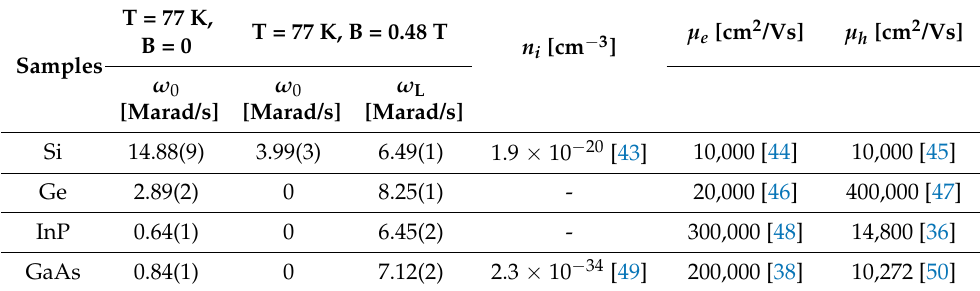
Table 4. The experimental Larmor, quadrupole frequencies without external magnetic field (B = 0) and with B = 0.48 T, intrinsic carrier concentration n i , and electron µ e and hole µ h mobilities at 77 K.